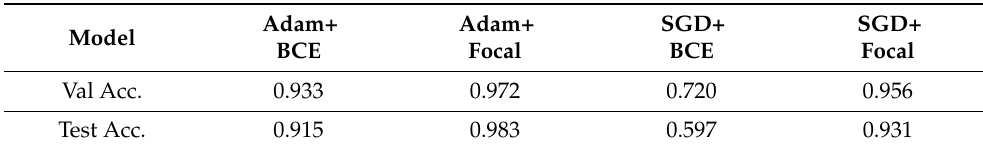
Table 3. Accuracy of sea–land segmentation using HED-Unet with different loss functions and optimizers.